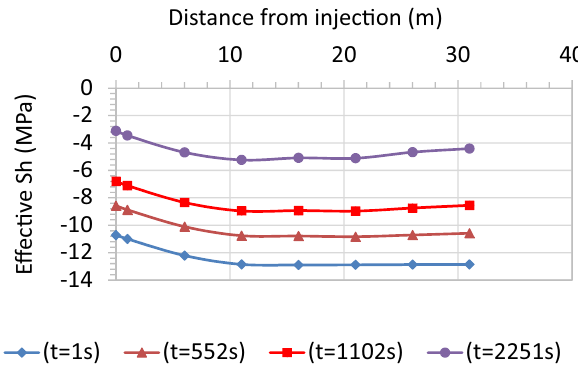
Fig. 5 Case 1 ( k = 23.4 mD): Effective maximum horizontal stress versus distance along the SRV length from the injection port at differ- ent injection times